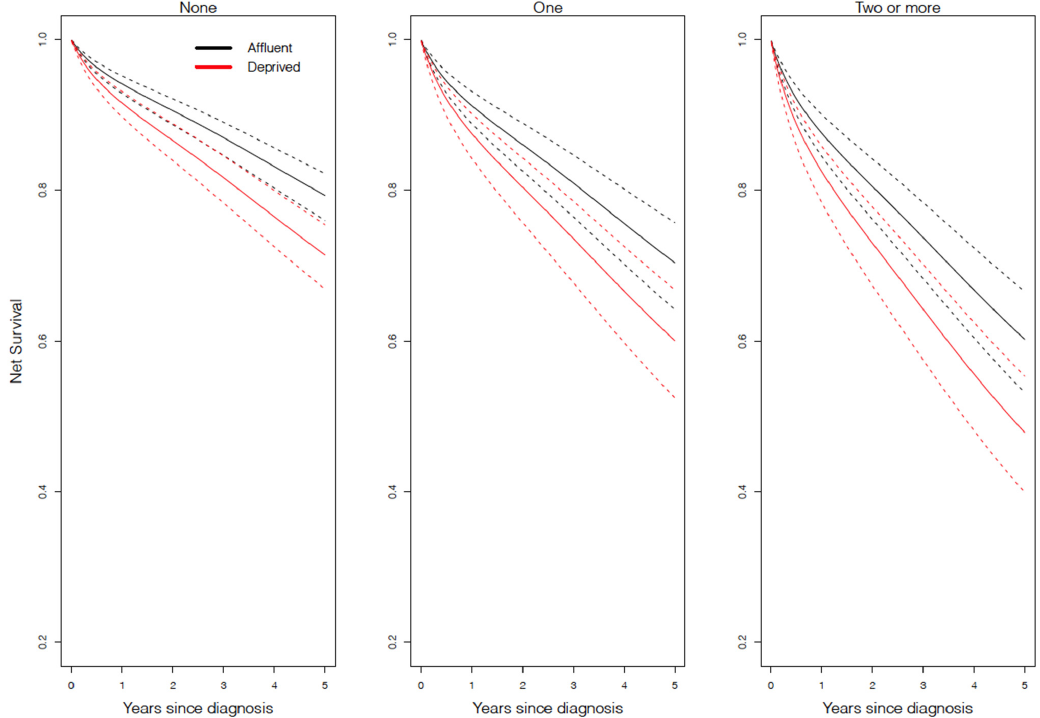
Figure 4. Net survival model-based prediction for follicular lymphoma for each comorbidity status by deprivation level ( n = 15,516) in England between 2005 and 2013. The values here are presented for 70-year-old white males diagnosed via a general practitioner referral. Values will change for other covariates, but the pattern observed here will remain.